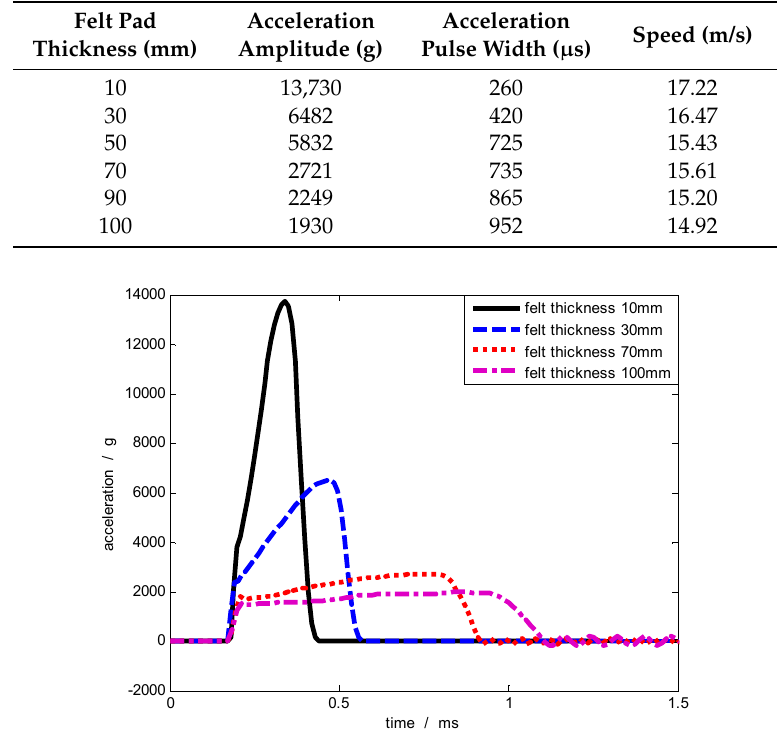
Figure 10. Acceleration pulse curves corresponding to different pad thicknesses.